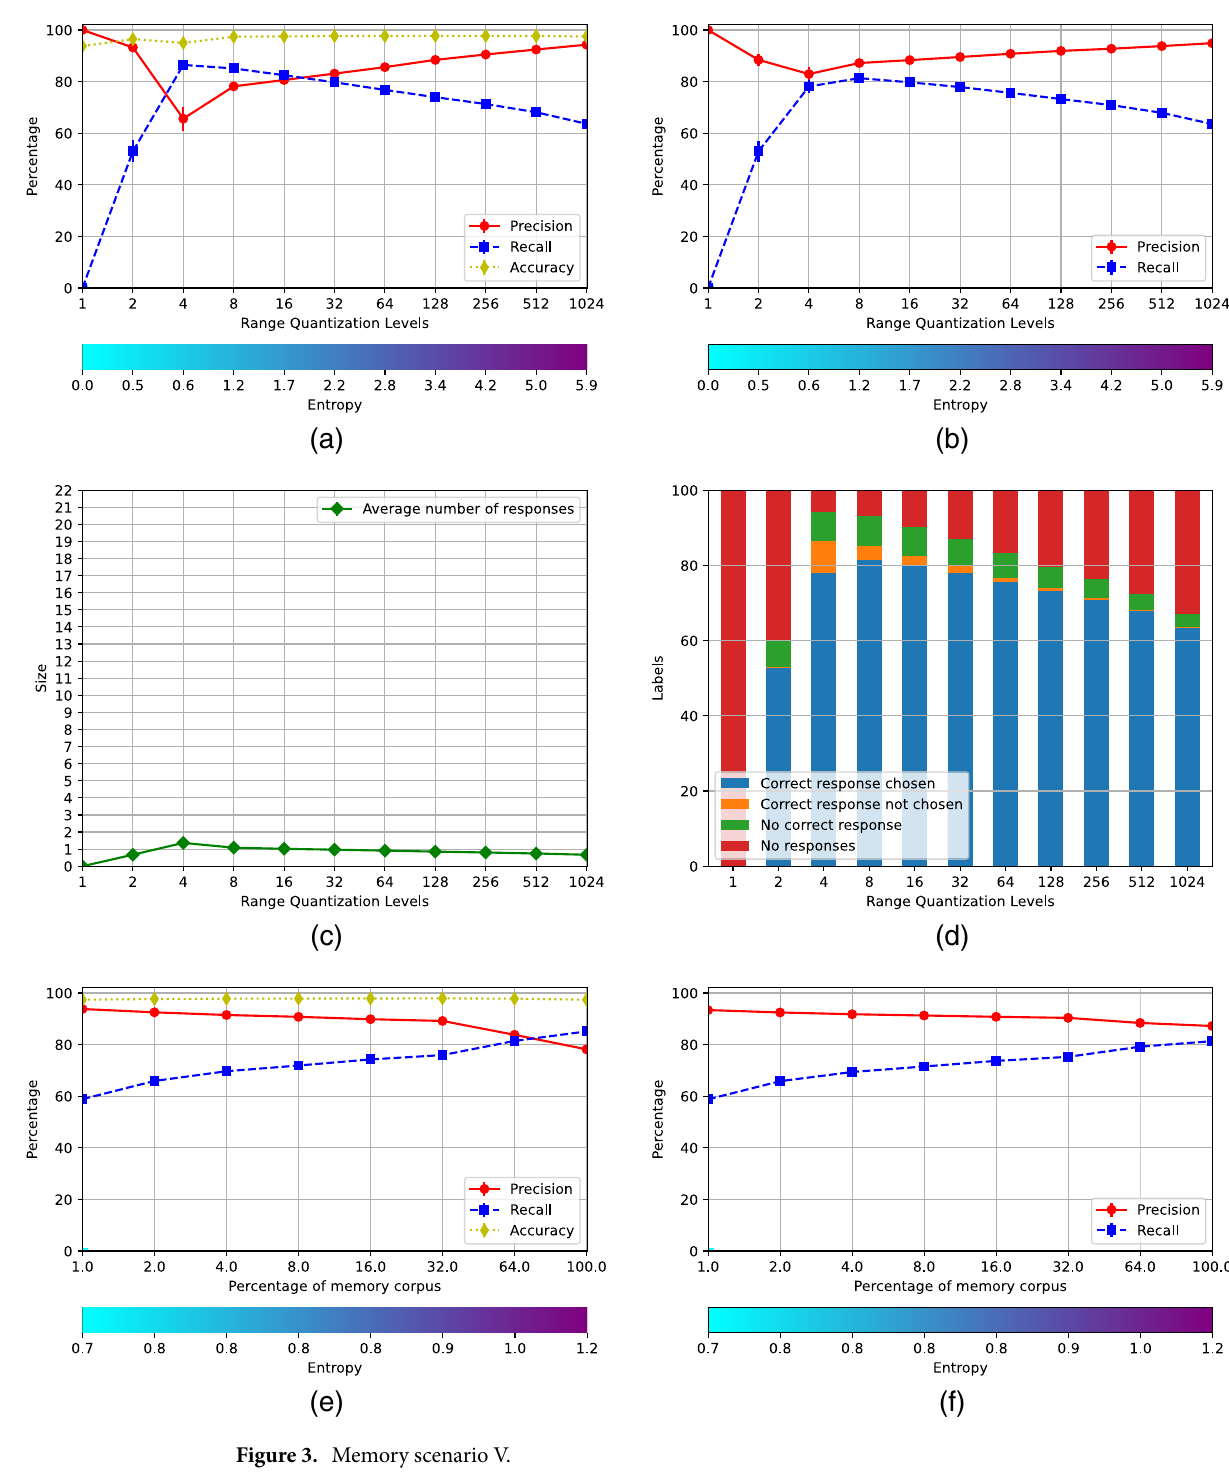
Figure 3. Memory scenario